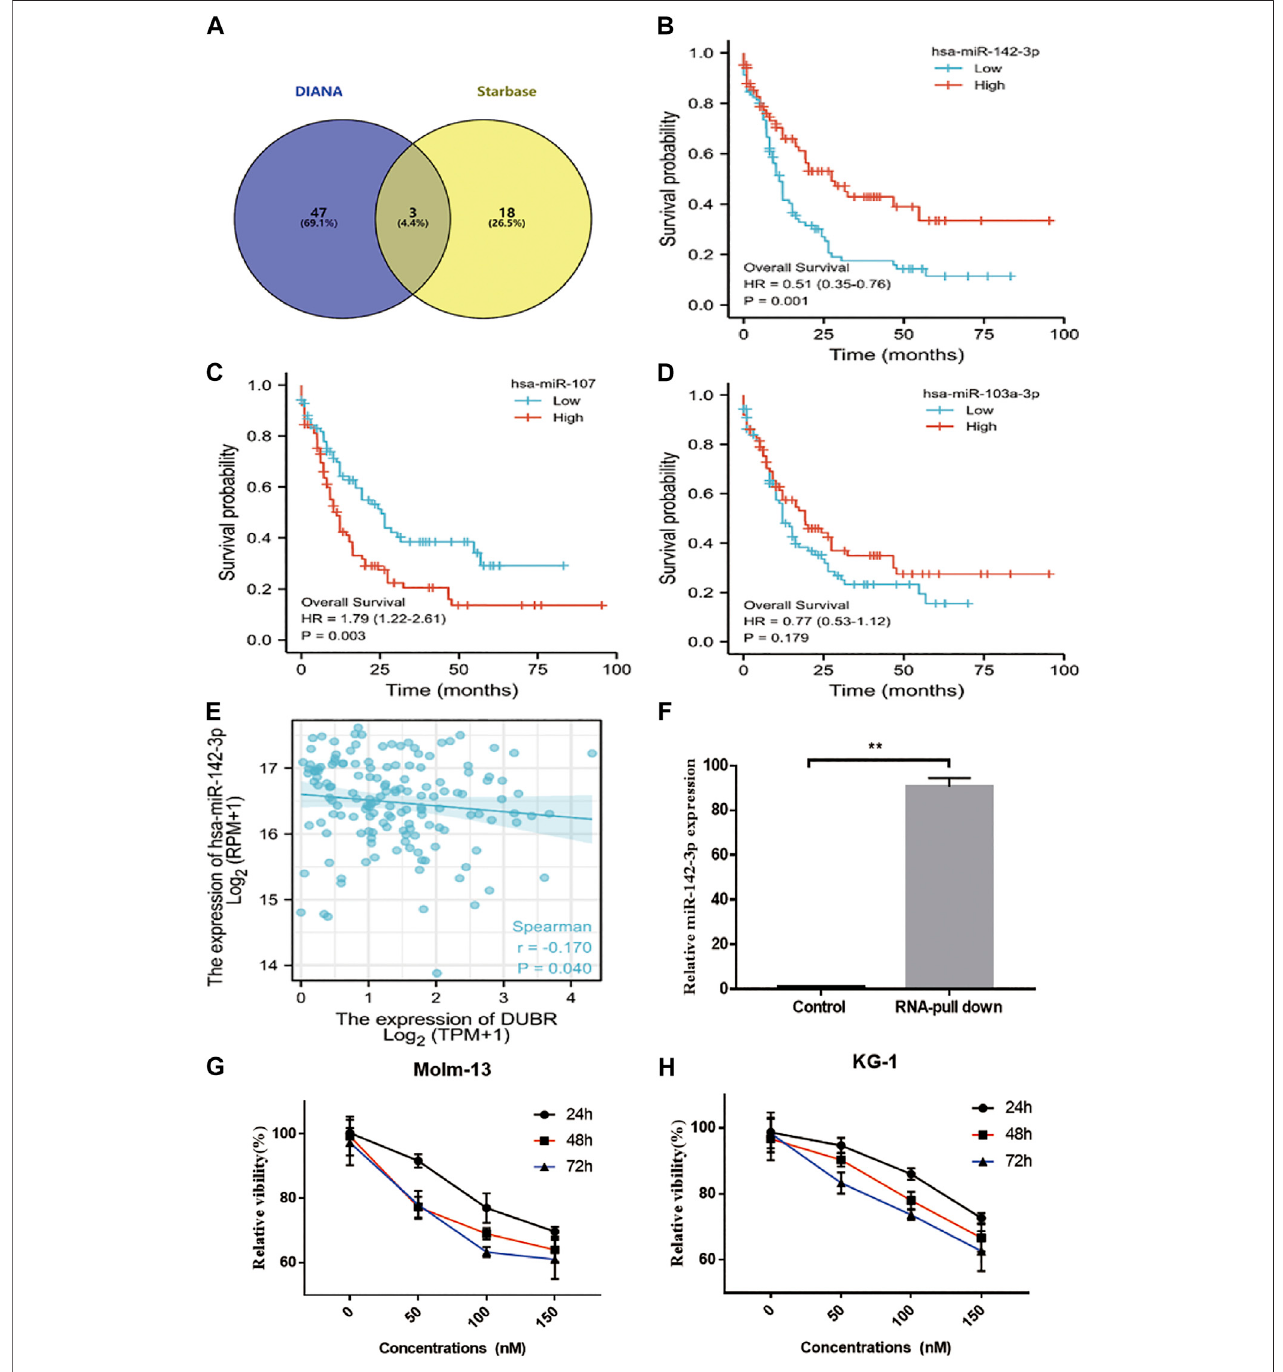
FIGURE 5 | DUBR sponged miR-142 – 3P and negatively modulated miR-142 – 3P expression. (A) Starbase2.0 and DIANA were used to predict the DUBR candidate sponge miRNA (miR-142-3P, miR-107, and miR-103-3P were involved in them). The OS plot of miR-142-3P. (B) , miR-107 (C) and miR-103-3P (D) in AML. (E) Spearman correlation analysis of relative expression between miR-142-3P and DUBR within AML bone marrow, p < 0.05. (F) RNA pull-down assay and qRT-PCR analysis for the detecting of endogenous miR-142-3P related to the DUBR transcript. SCR or miR-142-3P was transfected into Molm-13 (G) and KG-1 (H) cells. Then, cell viability was measured through CCK8